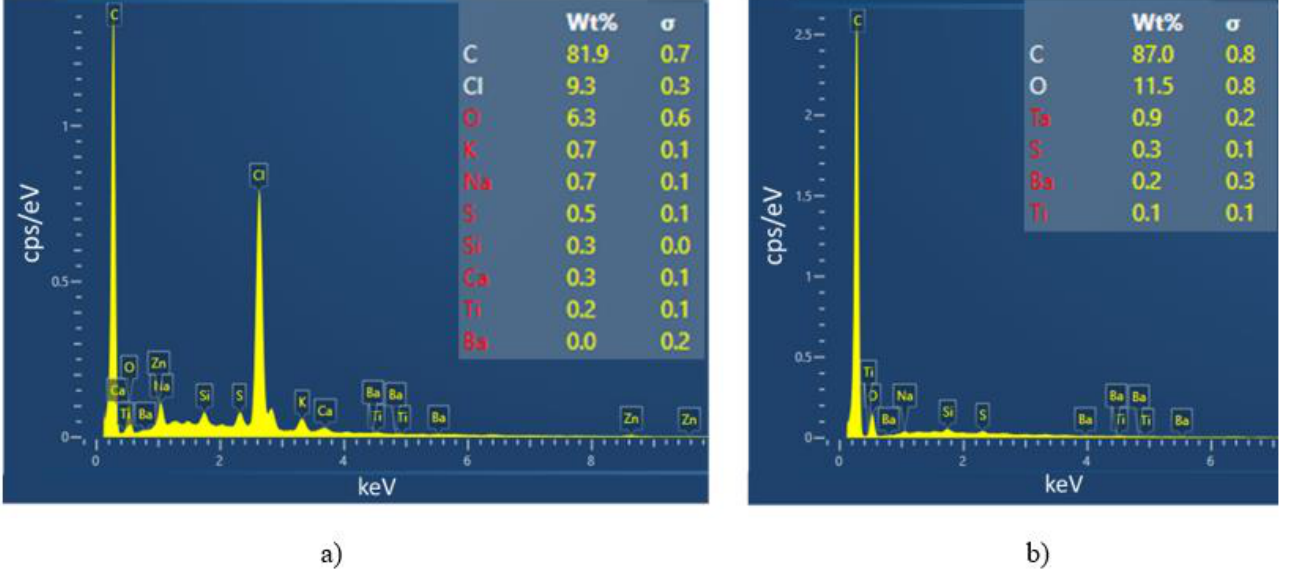
Figure 9. Elemental distribution maps based on SEM-EDS spectrum analysis for ( a ) the first ink, and ( b ) the second ink.